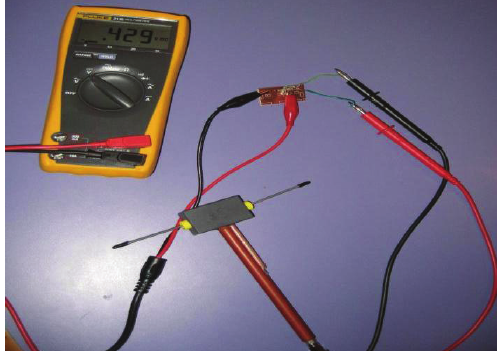
Figure 14: Voltage harvested by the RF signalharvester in an indoor area (more than 500 meters away from the base station).